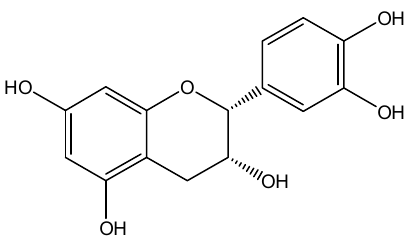
Figure 1. The chemical structure of ( − )-epicatechin.